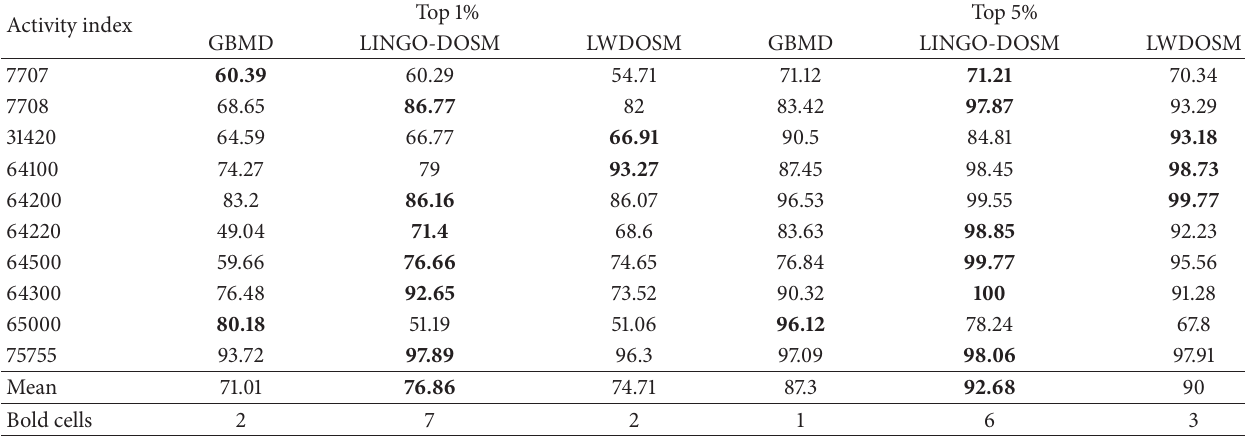
Table 13: Retrieval results of top 1% and 5% for data set DS2 compared with LWDOSM and Lingo-DOSM.